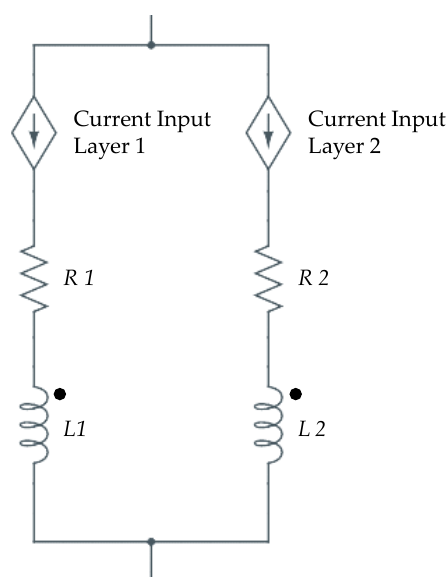
Figure 11. Equivalent electric circuit for the FEM model.